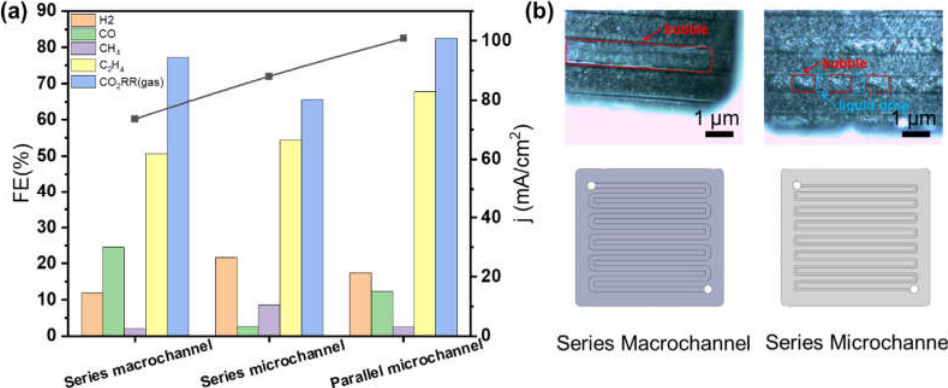
Figure 8. ( a ) The Faraday efficiency of gas products and current density with different channel structures; ( b ) microscopic images of the bubble dynamics. Operating parameter: Cell voltage 4.2 V, CO 2 gas flow rate of 10 sccm, anolyte flow rate of 10 sccm, and the anion exchange membrane of Sustainion X37-50 Grade T.